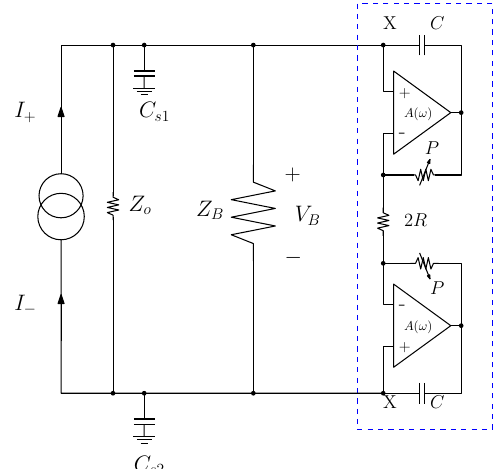
Figure 5. Compensation for NIC use in a tetrapolar EIT. The box highlighted in blue is the negative impedance converter (capacitance). Z B , Z o , C s 1 and C s 2 , are the body impedance, output impedance (total) of the current sources I + and I − , and the parasitic capacitances of the excitation source, respectively. Source: Adapted from